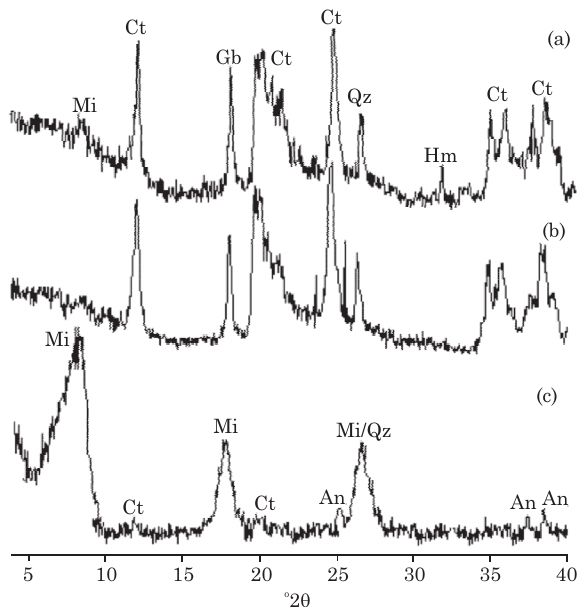
Figura 2. Difratogramas de raios X (radiação Cu K ααααα ) da fração argila do horizonte A1 do perfil 1, mostrando a mineralogia com os